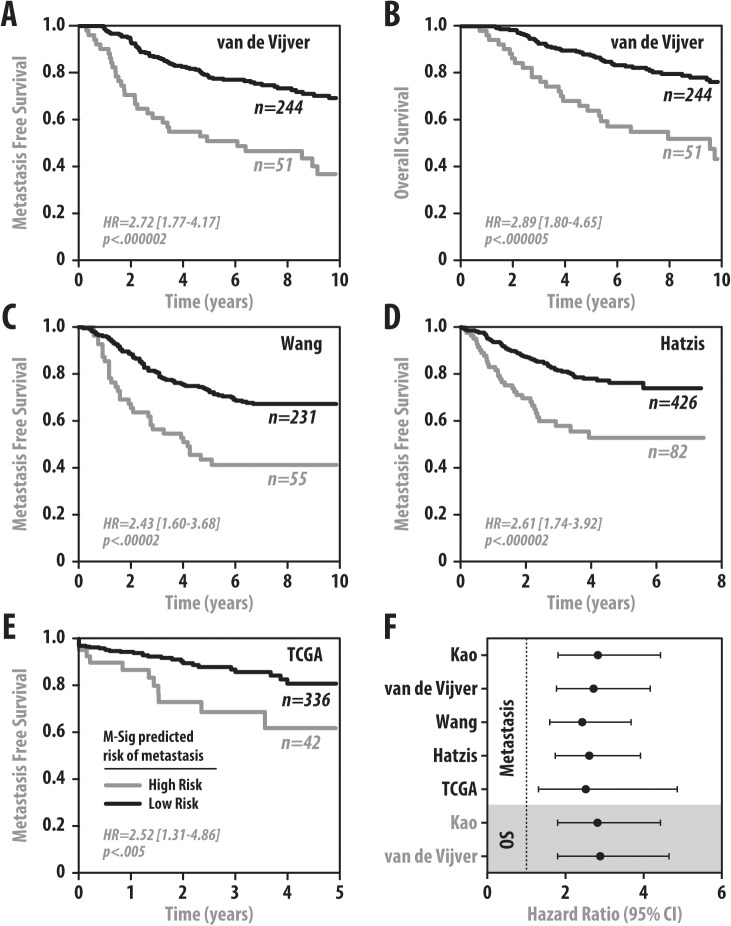
M-Sig Validation.M-Sig is able to risk stratify patients in several independent clinical datasets. Kaplan Meier survival estimate curves for M-Sig predictions for metastasis (A) and OS (B) in the van de Vijver cohort, metastasis in the Wang cohort (C), the Hatzis cohort (D), and the TCGA cohort (E). Hazard ratios (HR) are shown with 95% confidence intervals and a forest plot displays these univariate HRs with confidence intervals for all five cohorts and for both metastasis and overall survival (F). The OOB predictions were used for Kao as in Fig 2.